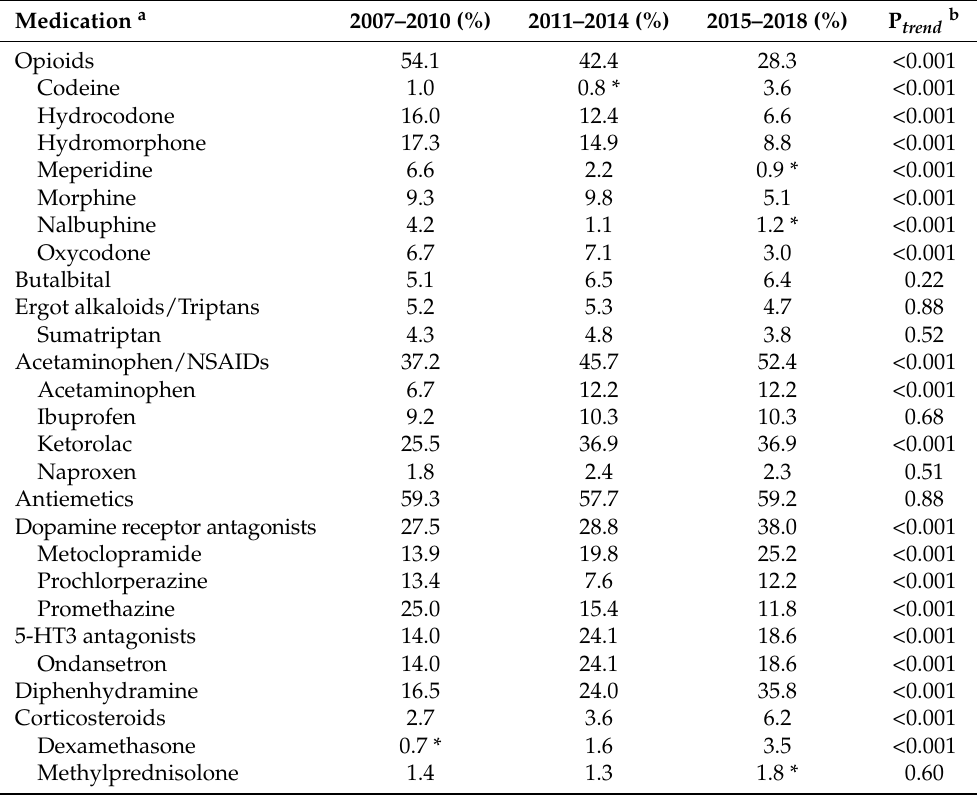
Table 2. Most frequently used medications among headache-related ED visits: 2007 to 2018 NHAMCS data.